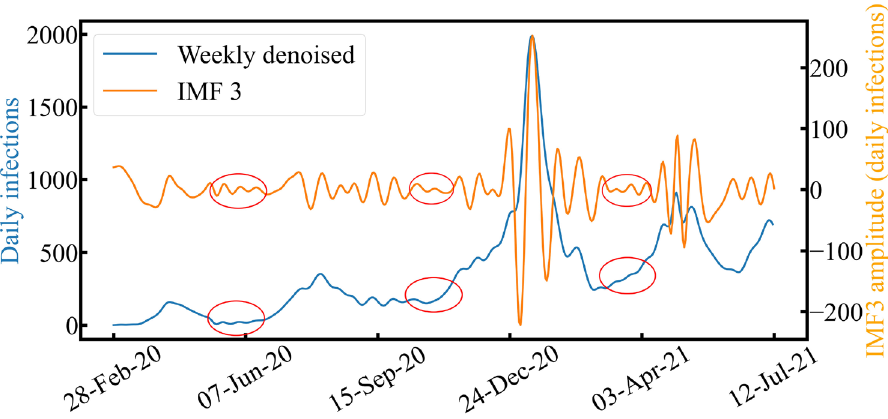
Figure 5. Comparison between weekly denoised trend and decomposed IMF 3